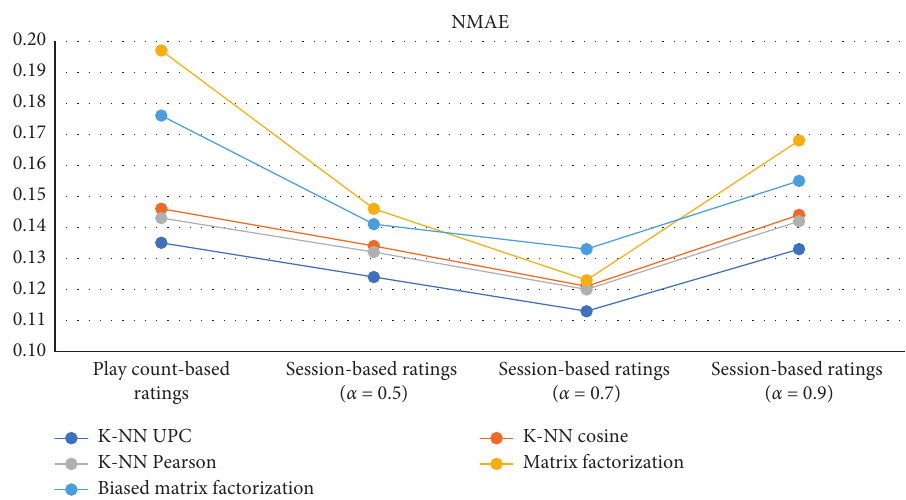
Figure 5: NMAE of the CF methods tested in the study for ratings calculated in four different ways.